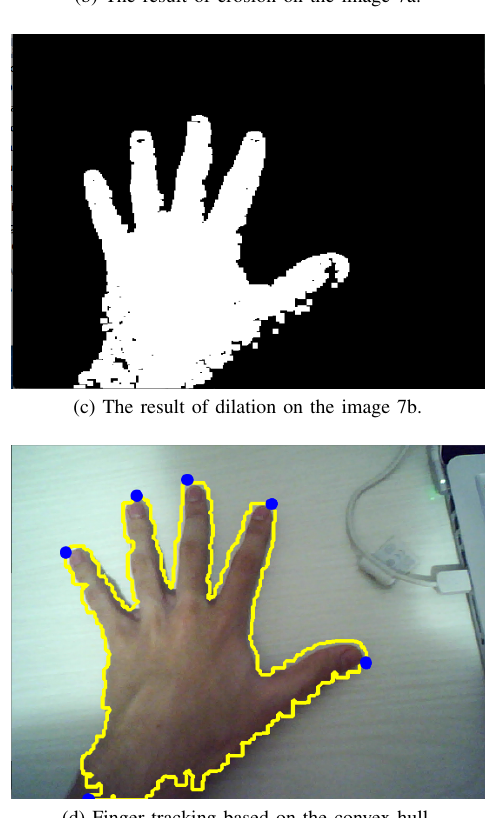
Fig. 7: Steps of the skin-based hand